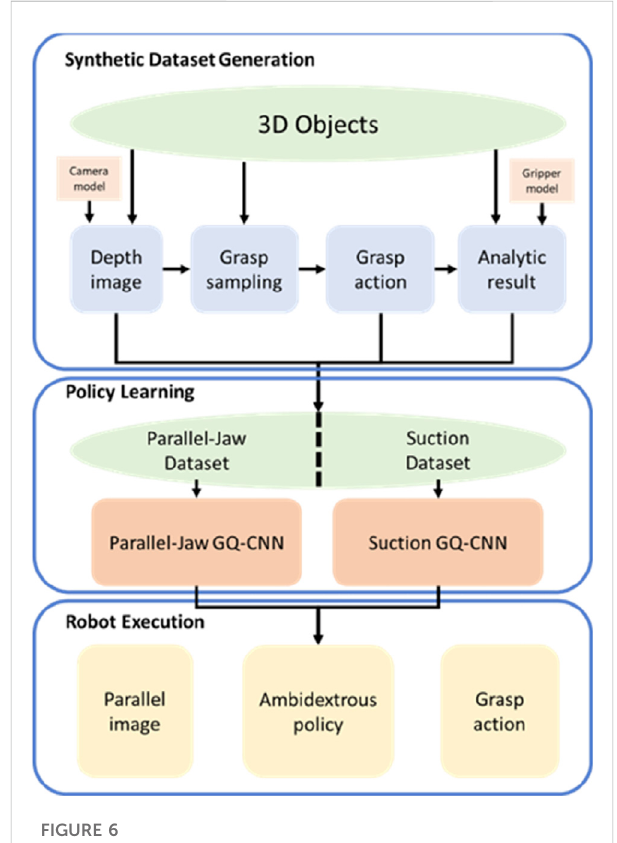
FIGURE 6 Ambidextrous grasping policy learning (Mahler et al.,